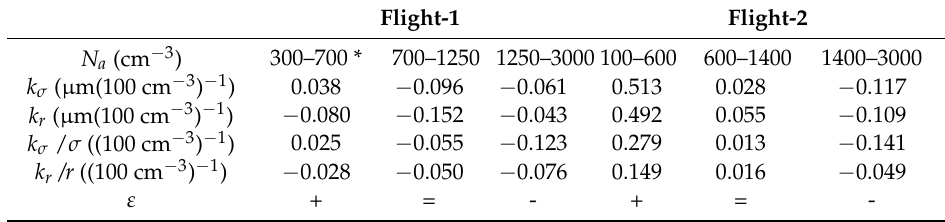
Table 3. The slopes of the standard deviation ( k σ ) and mean radius ( k r ) of CDSD with aerosol concentration ( N a ), and the ratios of k σ / σ and k r /r in different N a ranges, which corresponds to different change trends of dispersion ( ε ). The +, =, and - indicate an increase, invariant, and decrease of the ε change, respectively. Flight-1 Flight-2 N a (cm − 3 )